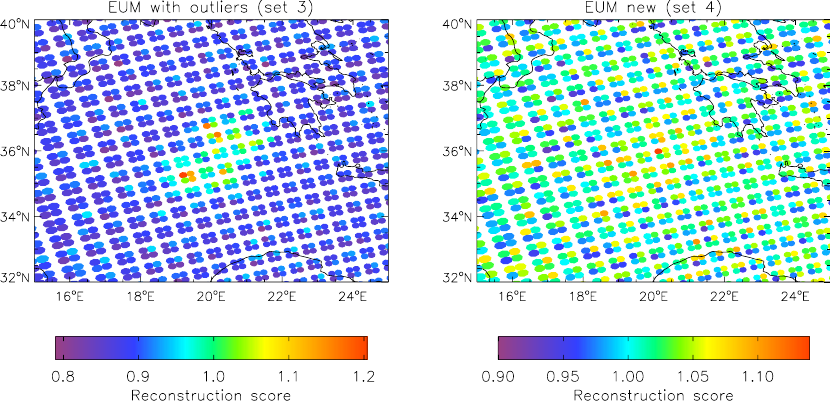
Fig. 13. Band 1 reconstruction scores for the case presented in Fig. 1, showing the improvement in homogeneity when the new set of EUMETSAT eigenvectors is used (see Sect. 4). Note the expanded scale in the right hand plot, allowing the background variability outside the biomass burning plume to be seen.